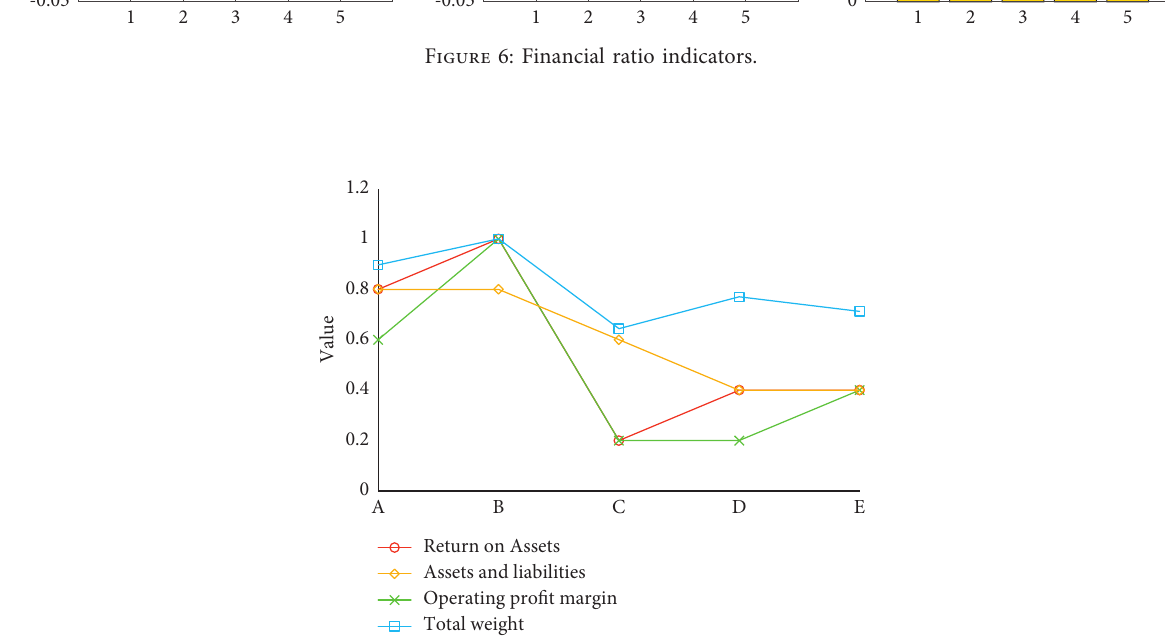
Figure 7: Characteristics of financial